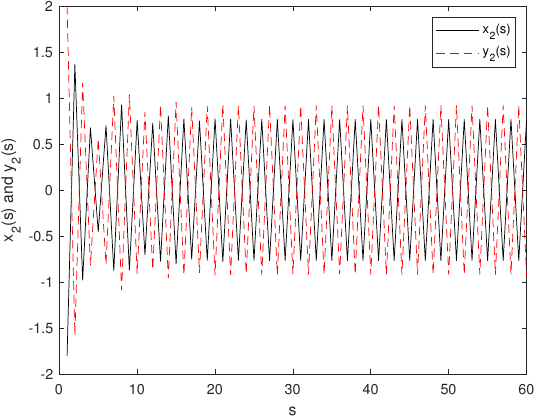
Figure 4. Trajectory curves of x 2 ( s ) and y 2 ( s ) without controller.